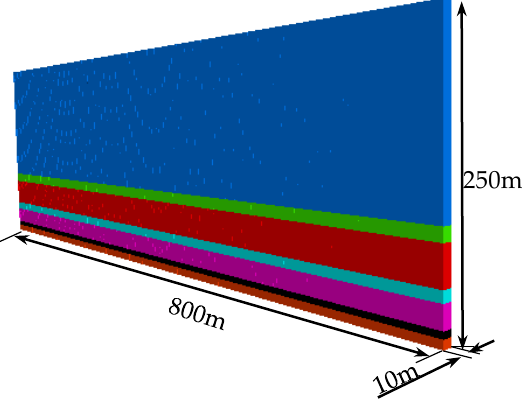
Figure 7. Mechanical model of numerical simulation.